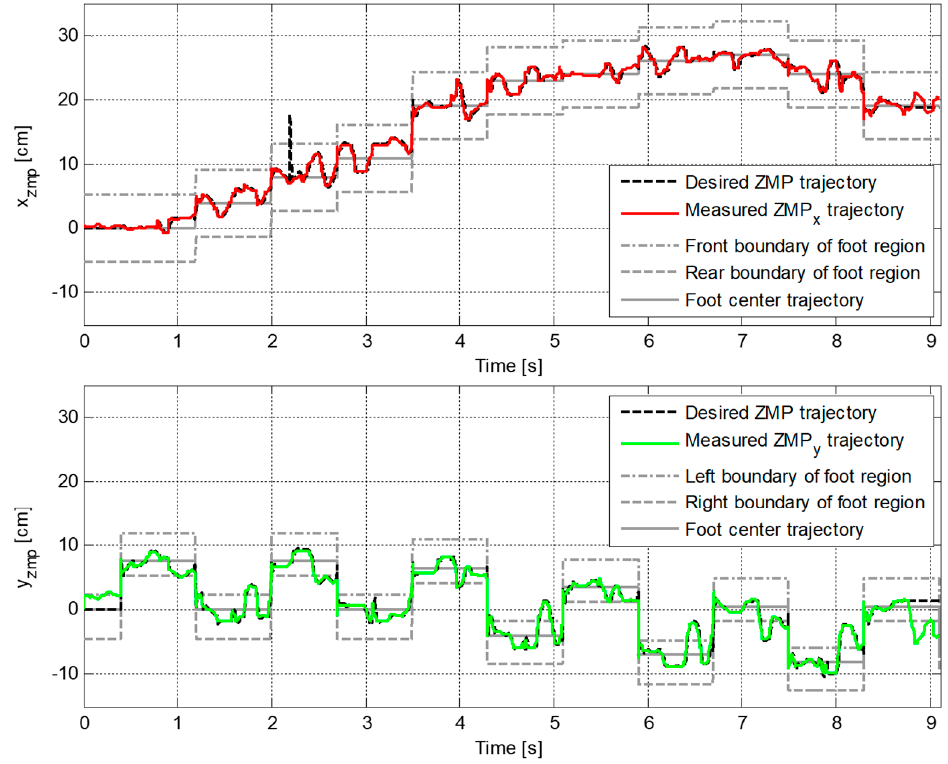
Figure 17. Error trajectory between reference and measured CPs, ξ ref and ξ c , in the experiment with the proposed CP-based walking stability controller.